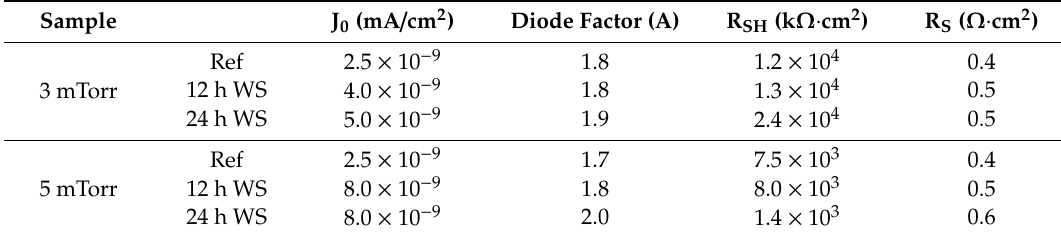
Table 2. Diode parameters (Dark J-V) of representative cells shown in Figures 4 and 5.